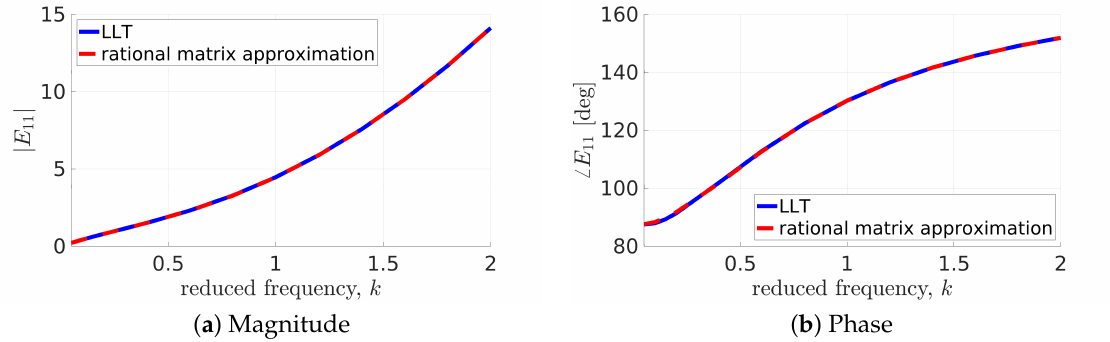
Figure 13. Comparison between computed and approximated transfer function E 11 ( k ) .